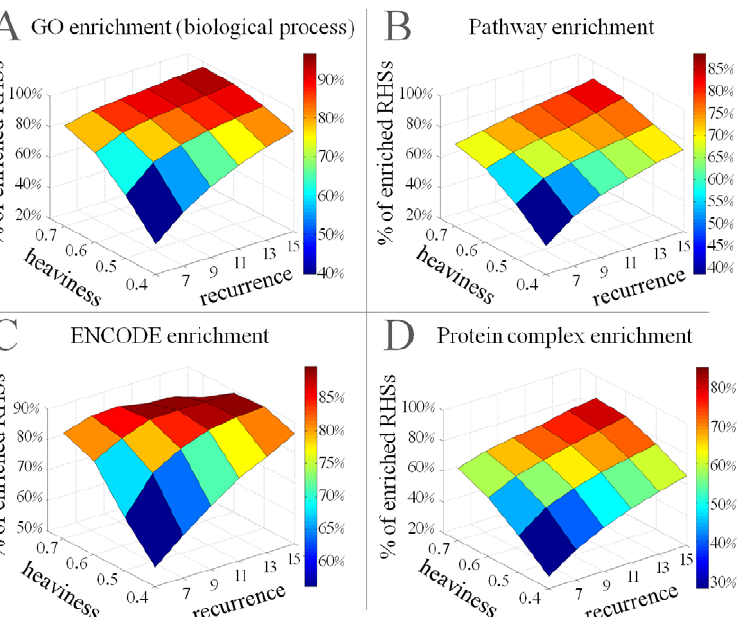
Figure 3. Evaluation of the functional, transcriptional, and protein complex homogeneity of RHSs with different recurrences and heaviness. Four types of databases are used: ( A ) Gene Ontology (GO) and ( B ) KEGG pathway databases for functional enrichment, ( C ) ENCODE database for transcriptional enrichment, and ( D ) CORUM database for protein complex enrichment. It can be seen that the percentage of potential functional, transcriptional, and protein complex modules increases with the heaviness and recurrence of the RHSs.